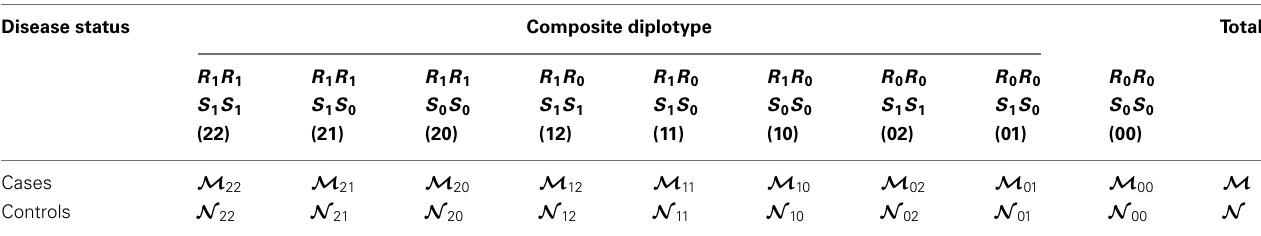
Table 3 | Frequencies of across-block composite diplotypes in both cases and controls, assuming that AB is the risk haplotype for block 1 and CD is the risk haplotype for block 2.